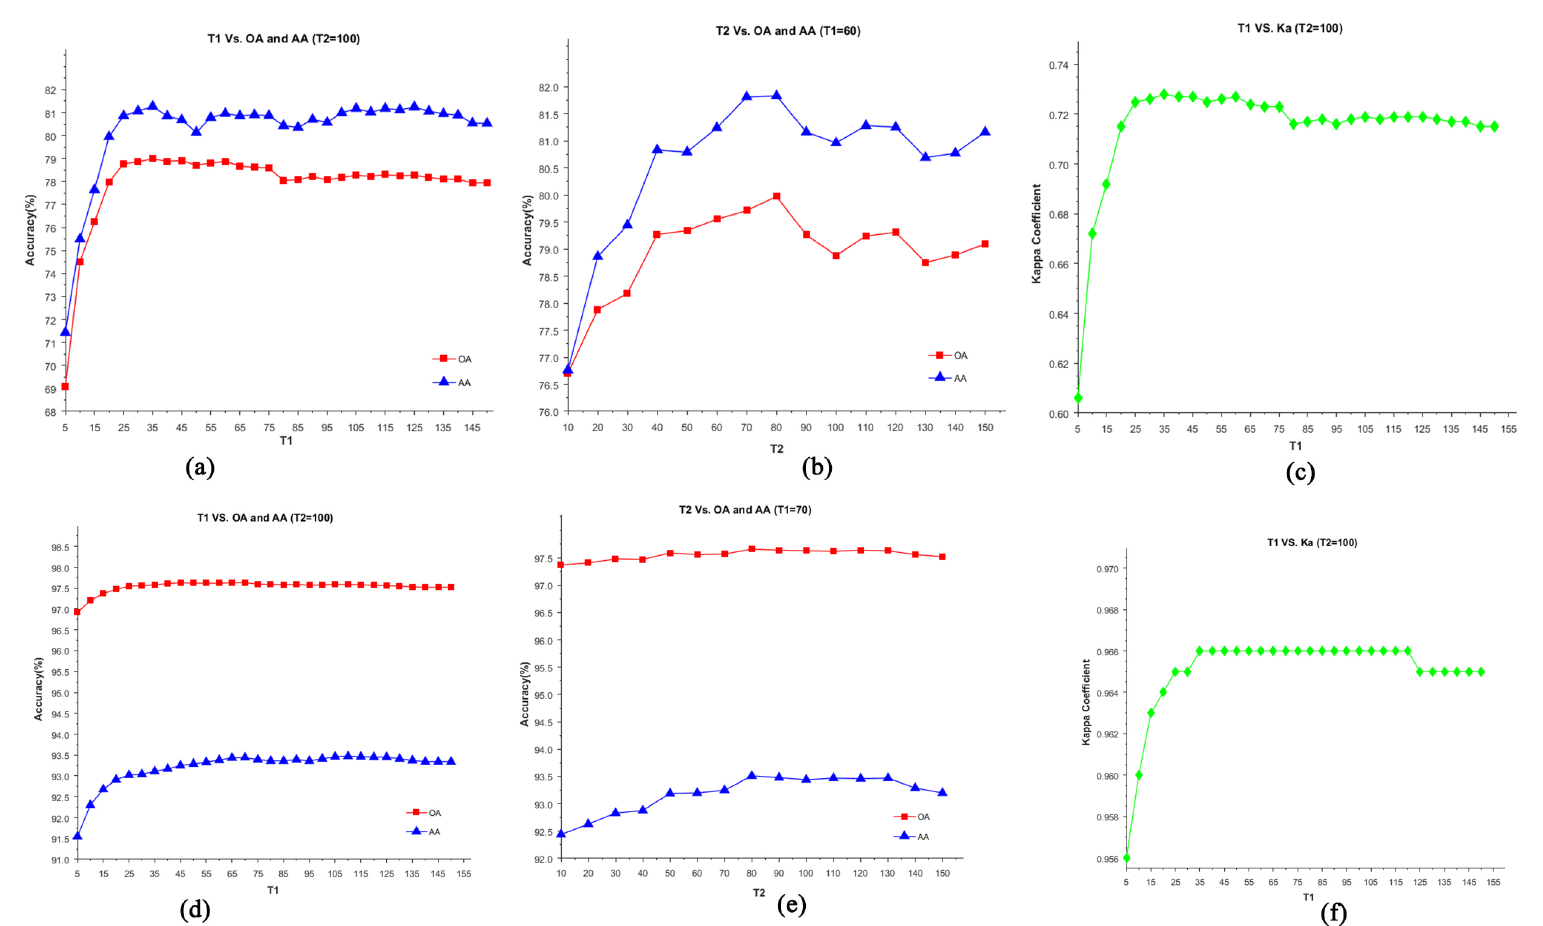
Figure 9. Relationship between classification maps and parameter settings (T 1 and T 2 ) of the proposed D-AMVS method: ( a – c ) are the relationships between T 1 , T 2 , and OA/AA/Ka, respectively, for the Pavia University image, and ( d – f ) present the relationships between T 1 , T 2 , and OA/AA/Ka for the Pavia Center image,